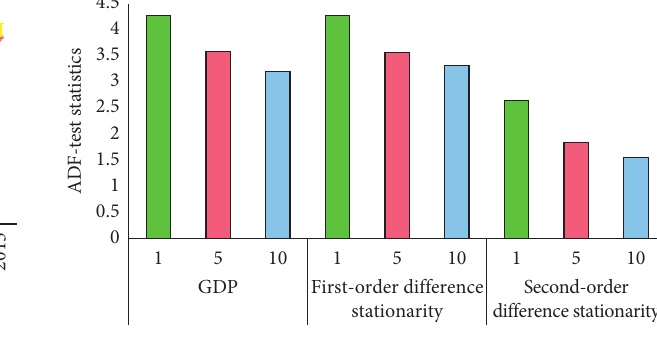
Figure 5: Stationarity of GDP series.